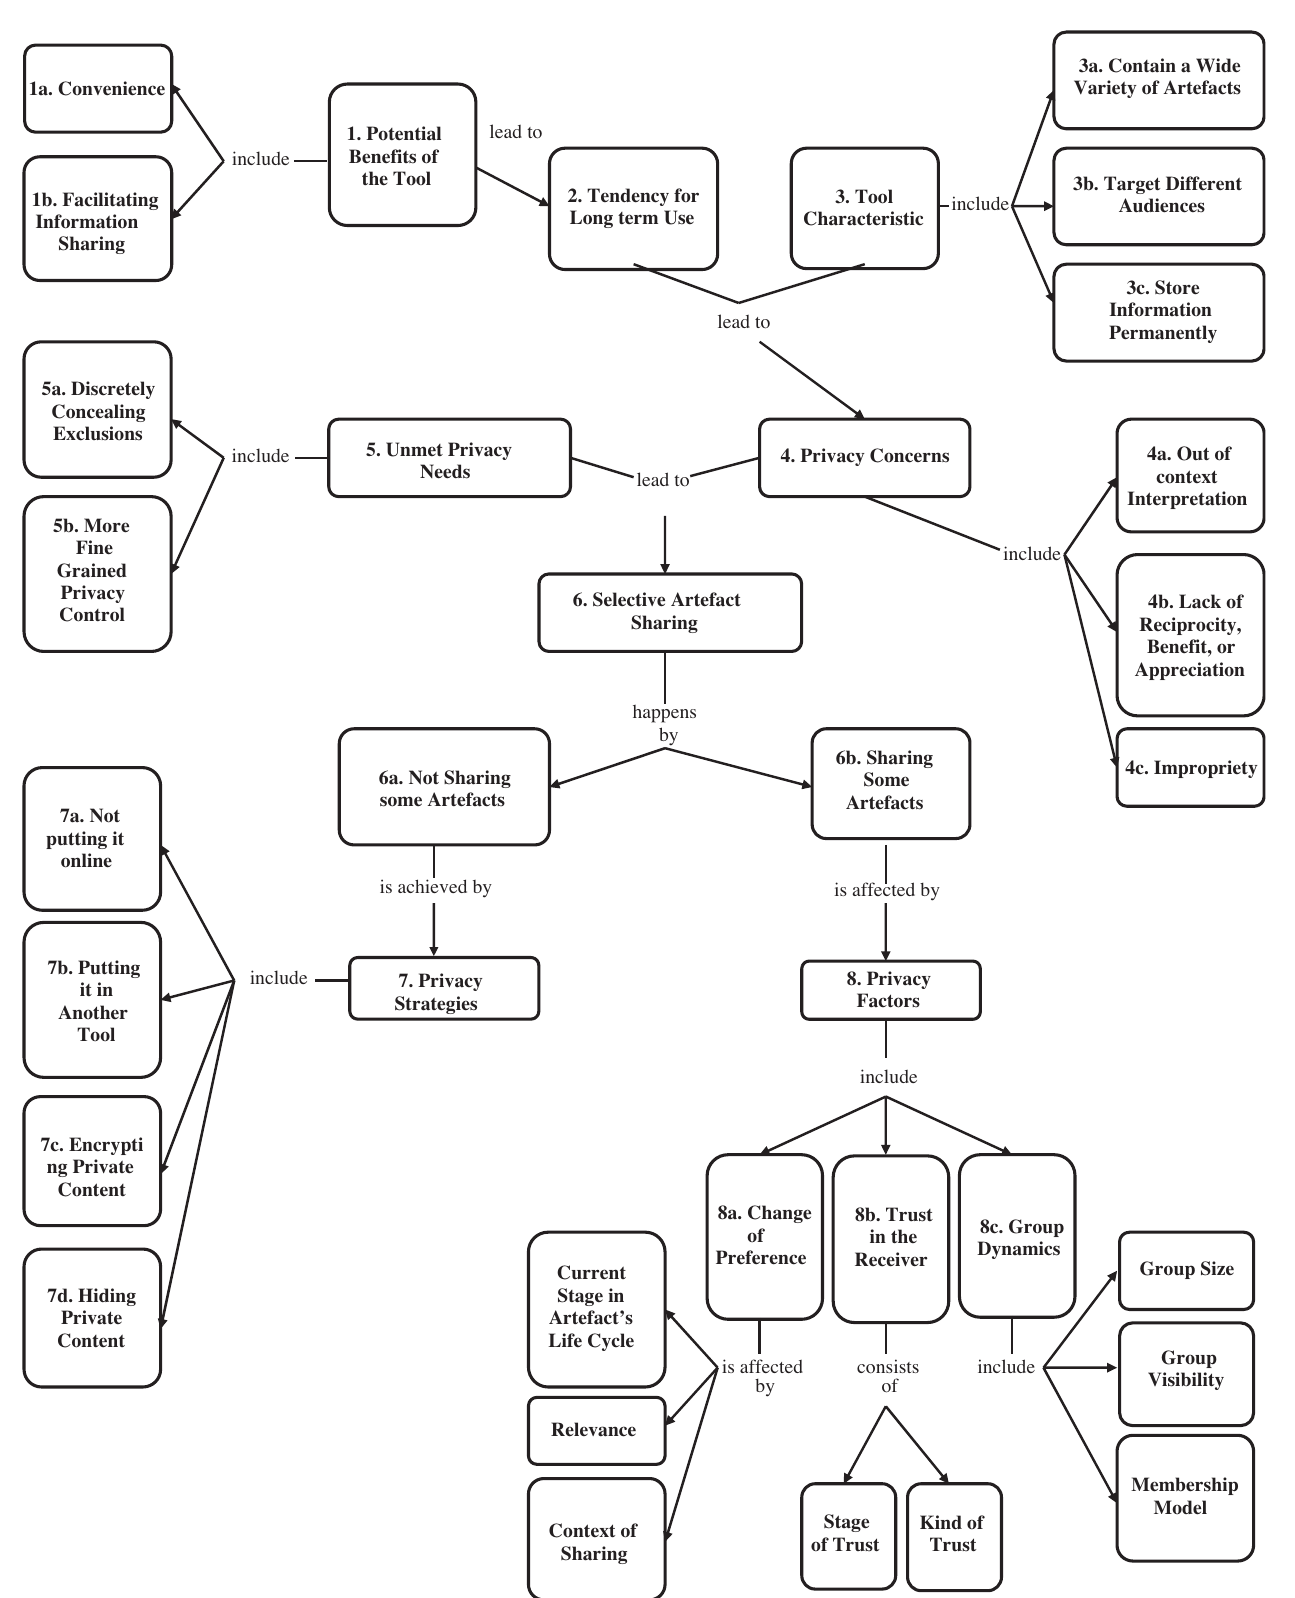
Figure 1. A concept map of information sharing behaviour in a social software